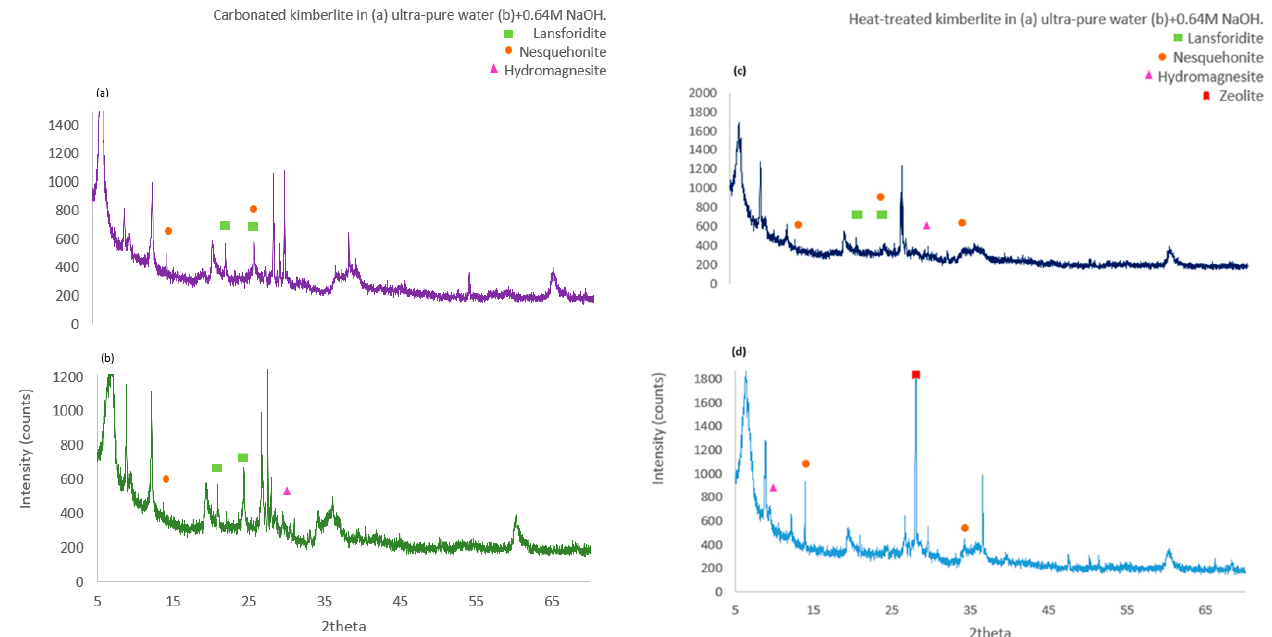
Figure 10. XRD diffractograms of: kimberlite carbonated at 200 °C and 60 bar in ultrapure water ( a ) and in 0.64 M NaOH ( b ); heat-treated kimberlite carbonated at 200 °C and 60 bar in ultrapure water ( c ) and in 0.64 M NaOH ( d ). Figure 10c,d discloses XRD diffractograms of heat-treated kimberlite carbonated in